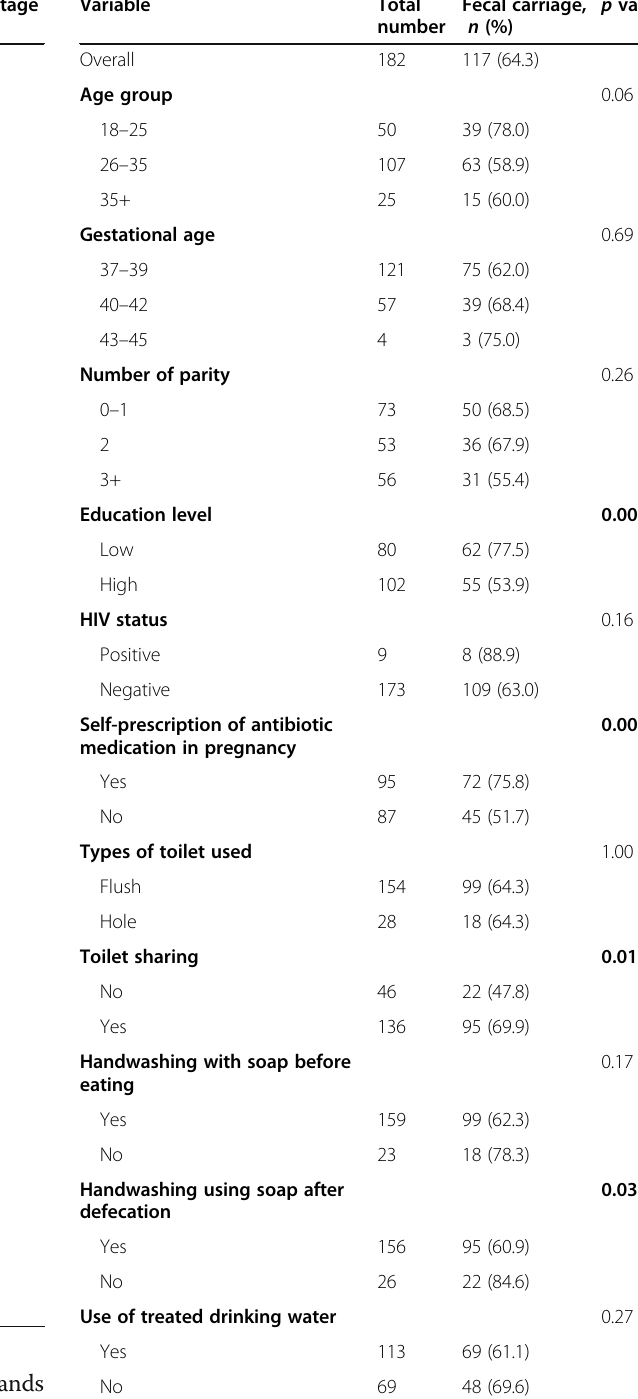
Table 1 Distribution of socio-demographic, clinical, and hygienic variables among pregnant women ( N = 182)